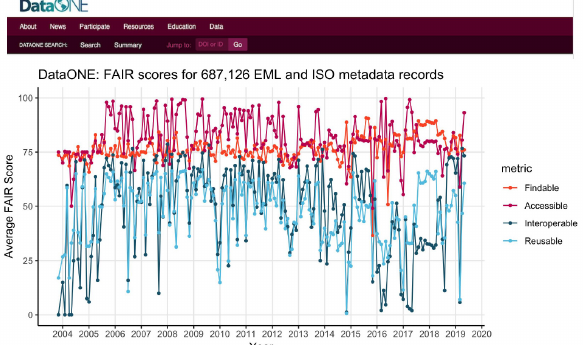
Figure 1 Example of monthly average FAIRness